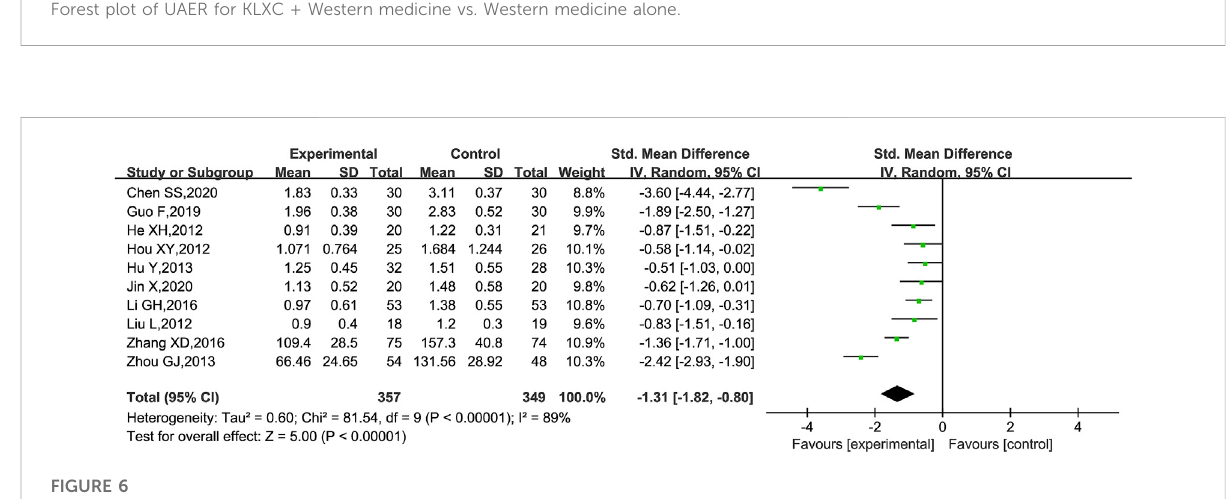
FIGURE 6 Forest plot of 24hUpro for KLXC + Western medicine vs. Western medicine